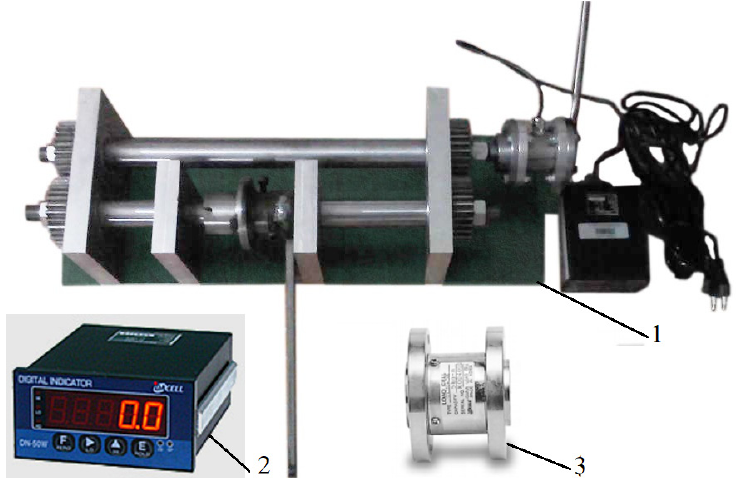
Figure 6. The measurement model and instruments: (1) General view of the test bench; (2) Digital Indicator DN–50W; (3) Torque sensor TCN.